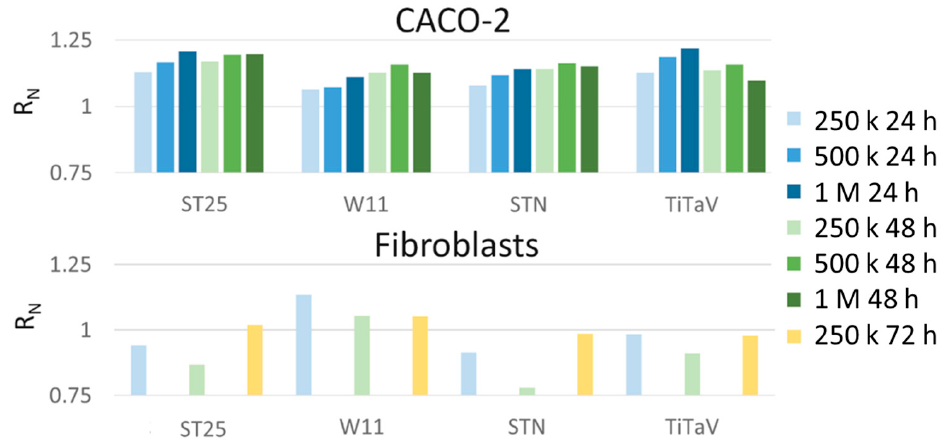
Figure 13. Sensor responses to CACO-2 and fibroblast cell lines. Cells plated at 250 K (light colors), 500 K (medium dark colors), and 1 M (darkest colors) cells/dish, measured after being withdrawn from the incubator at 24 h (blue), 48 h (green) and 72 h (orange); cells sorted for the same concentration at different times of incubation. The sensor responses not visible in the histograms were smaller than 0.75.